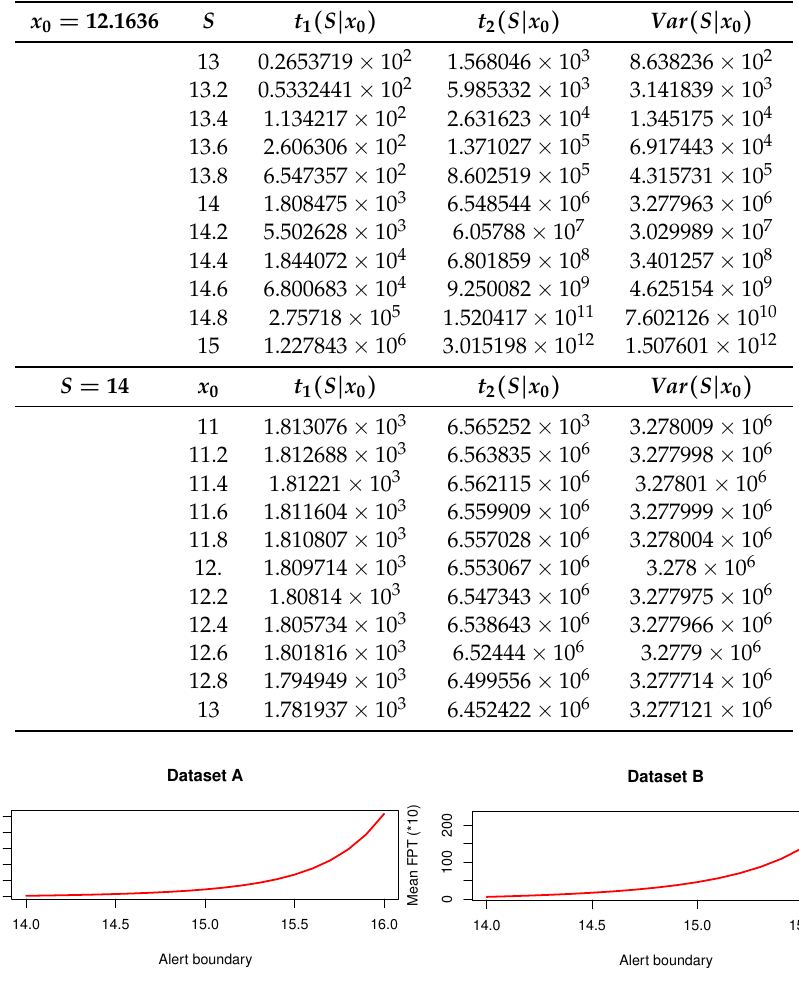
Table 6. For Dataset B, second period, mean, second order moment, and variance of the random variable T x through the threshold S for various values of S and of x 0 . 0